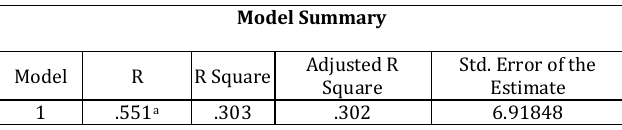
Figure 6: Correlation between traffic density and mean noise level, dB (A)